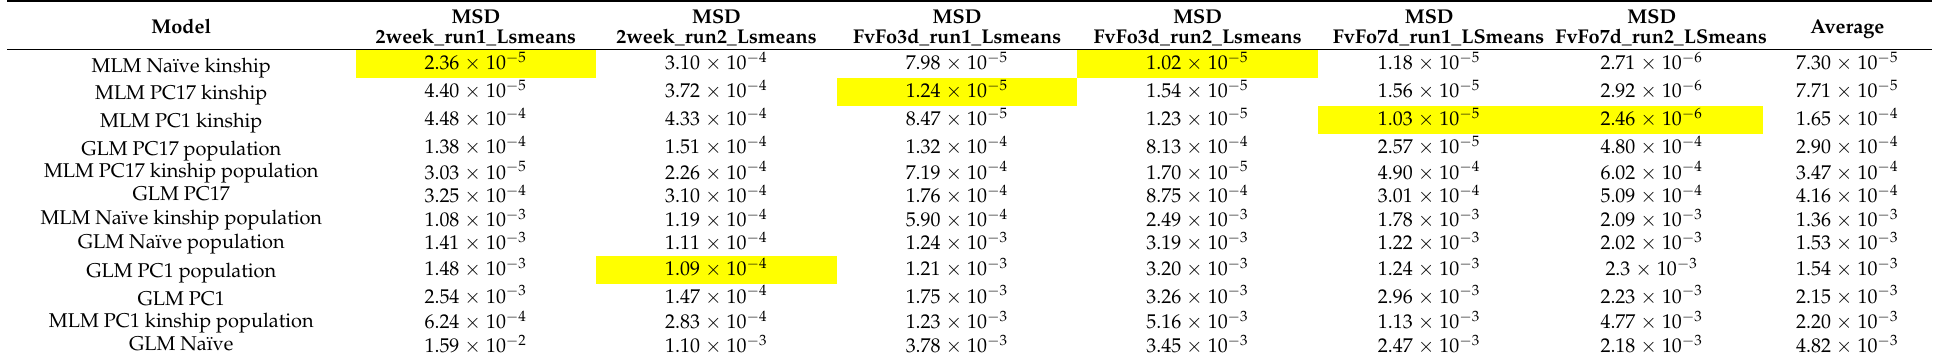
Table 2. Mean Squared Distance (MSD) analysis to assess the fit of the various models for each of the experimental runs for the three phenotypic analyses. The table is ordered based on the average MSD for all six analyses. Highlighted values indicate the best model for each